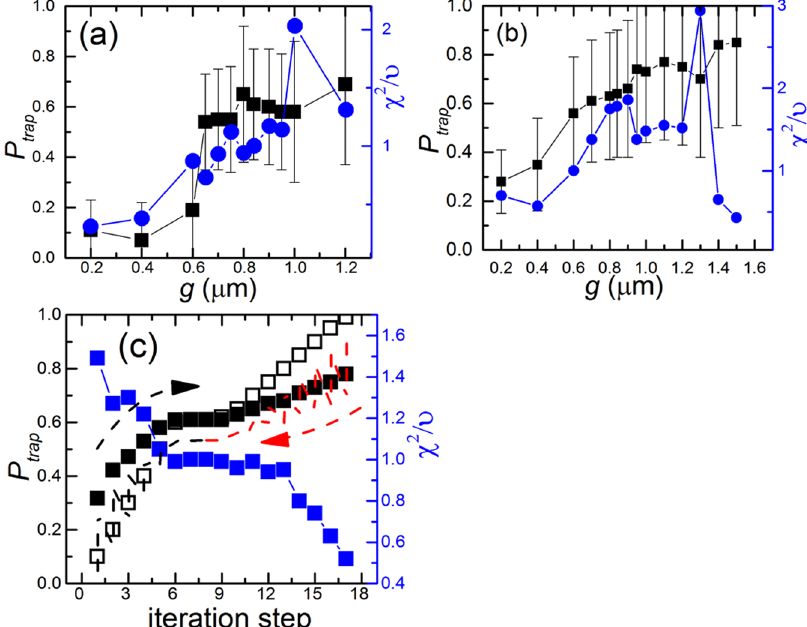
Figure 6. Systematic testing of optimized regimes in the Viterbi fitting at different trapped step sizes ( g ). The optimal values of P trap (black) and the fit quality ( χ 2 / υ , blue) were obtained by changing the trapped step size in the Viterbi fitting routine to the displacement trajectory obtained at ( a ) d = 1.6 μ m and ( b ) 2.2 μ m. Dashed lines indicate χ 2 / υ = 1, where the fitting routine yields optimized results. ( c ) The values of the input P trap (open black square), the output P trap (solid black square), and the goodness of the fit (solid blue square) were obtained in individual iteration steps. The black arrow with black dash lines indicates the iteration process starting from 0.1 till it reaches the converged P trap . The iteration starting from 0.95 are shown as red arrow with red dash